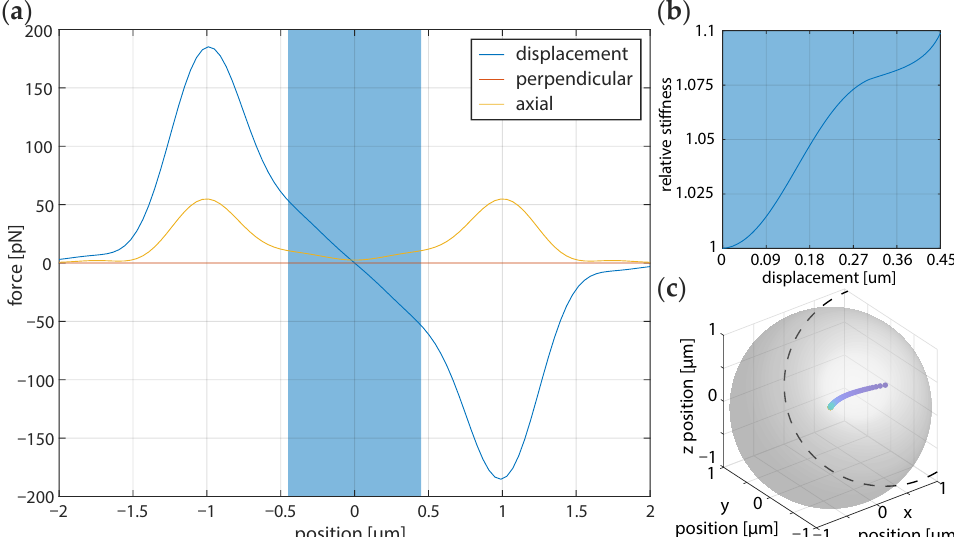
Figure 1. Calculation of the force extension curves for the optical force acting on particles of radius 1.0µm for displacement along one axis in the beam focal plane. ( a ) The approximately linear region is marked by the shaded rectangle. ( b ) The approximate stiffness (initial force divided by displacement from equilibrium) of the optical trap in the shaded region relative to the equilibrium value. ( c ) Trajectory for such a particle from a displacement of 1µm along one of the transverse axes with an overlaid shaded region representing the outer surface of the sphere. It moves along the beam axis due to scattering